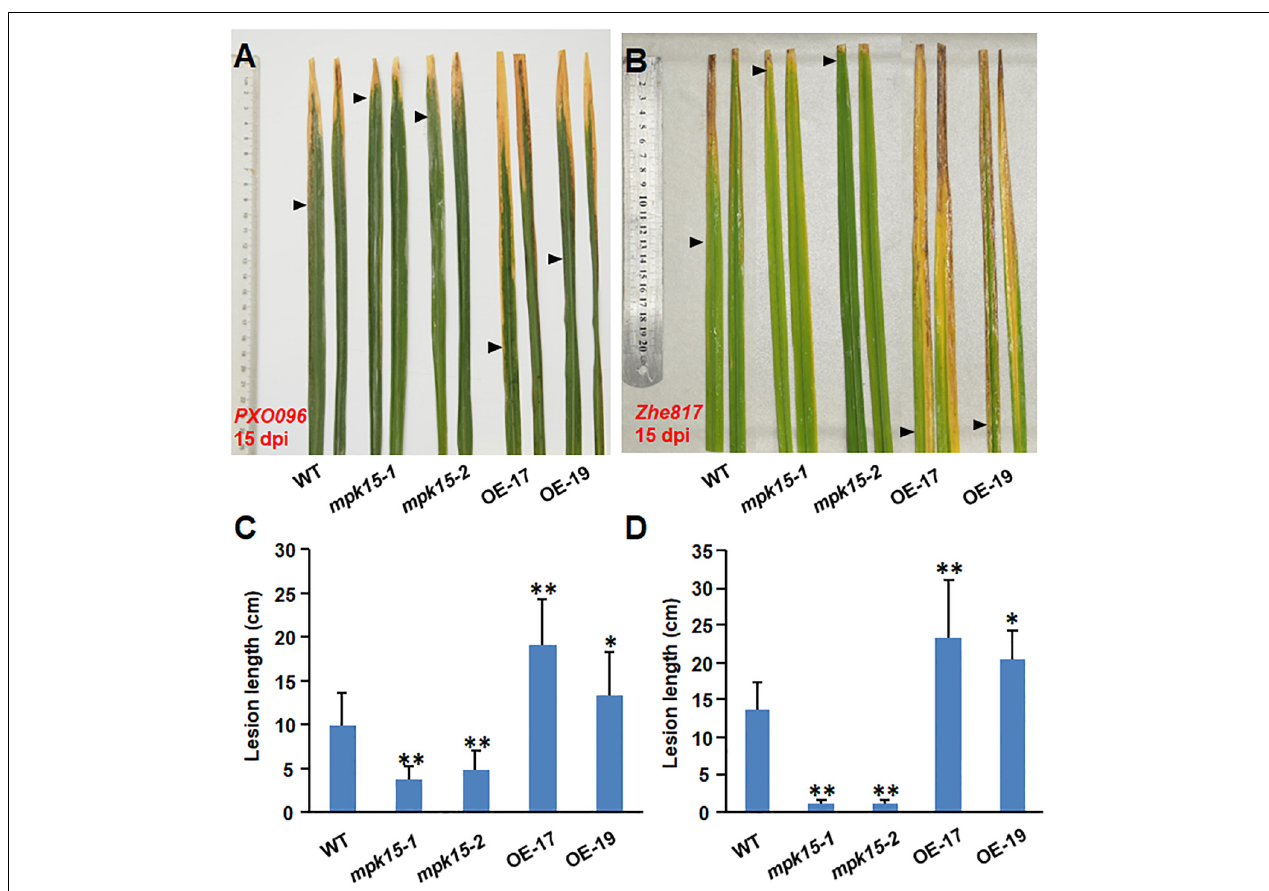
FIGURE 4 | OsMPK15 negatively regulates the bacterial disease resistance to X. oryzae pv. oryzae . The WT, mpk15 mutant, and OsMPK15-OE plants were inoculated with Xoo strains PXO96 and Zhe817 using the leaf clipping method at the 90-days-old (booting stage). (A,B) Disease symptom on the PXO96 and Zhe817 -inoculated leaves at 15 dpi. Rulers were indicated on the left. (C,D) Lesion length on the inoculated leaves at 15 dpi. At least 12 plants in each experiment were used for measurement of the lesion length. Data presented in (C,D) are the mean ± SD from three independent experiments. ∗ P ≤ 0.05; ∗∗ P ≤ 0.01 (Student’s t